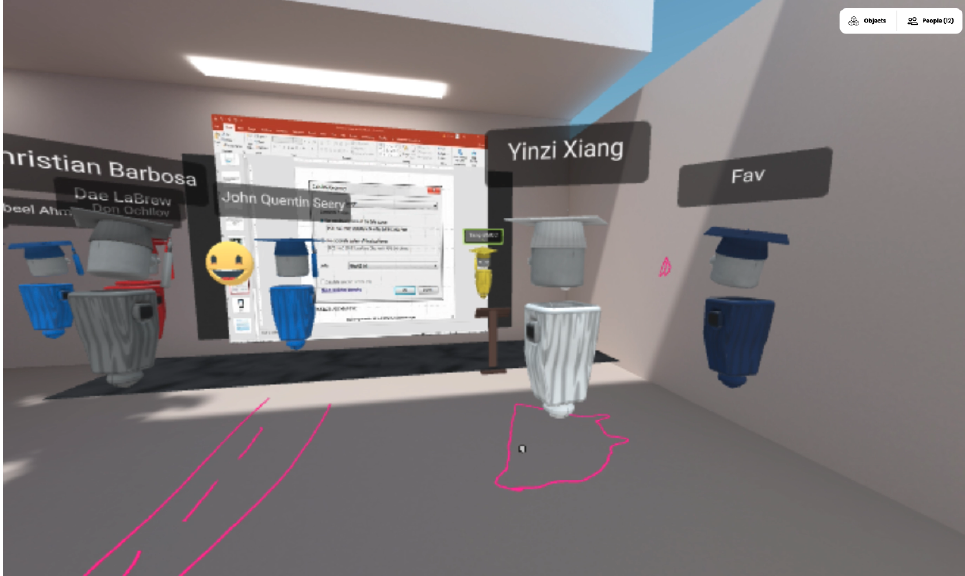
Figure 2. A Class in the CUNY Affective and Responsive Virtual Environment (CARVE) Hub. We can see students focusing on the PowerPoint, drawings on the ground, and a captured smile